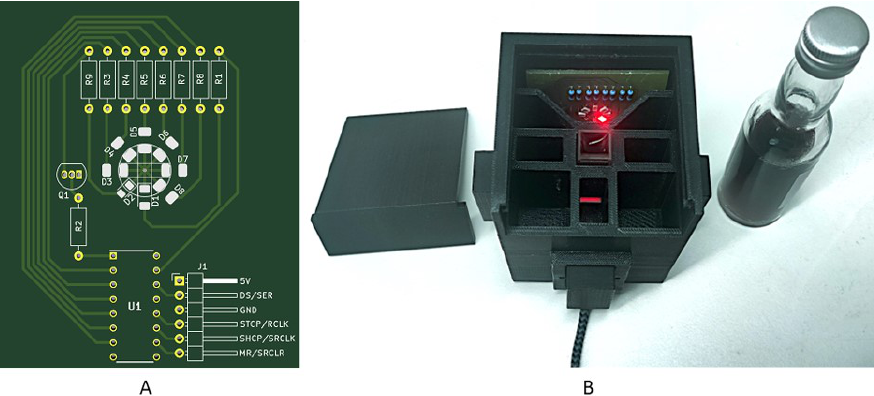
Figure 2. ( A ) Developed LED board for color measurement with the portable analysis system. Eight SMD-LEDs with the needed wavelengths (Table 1) were placed in a circle (D1–D4). The required series resistors were connected (R1–R9). The LEDs were controlled by a shift register (U1). The board was developed in KiCAD (KiCAD version 5.1.9, Jean Pierre Charras, France). The LED board can be placed into the portable analysis system ( B